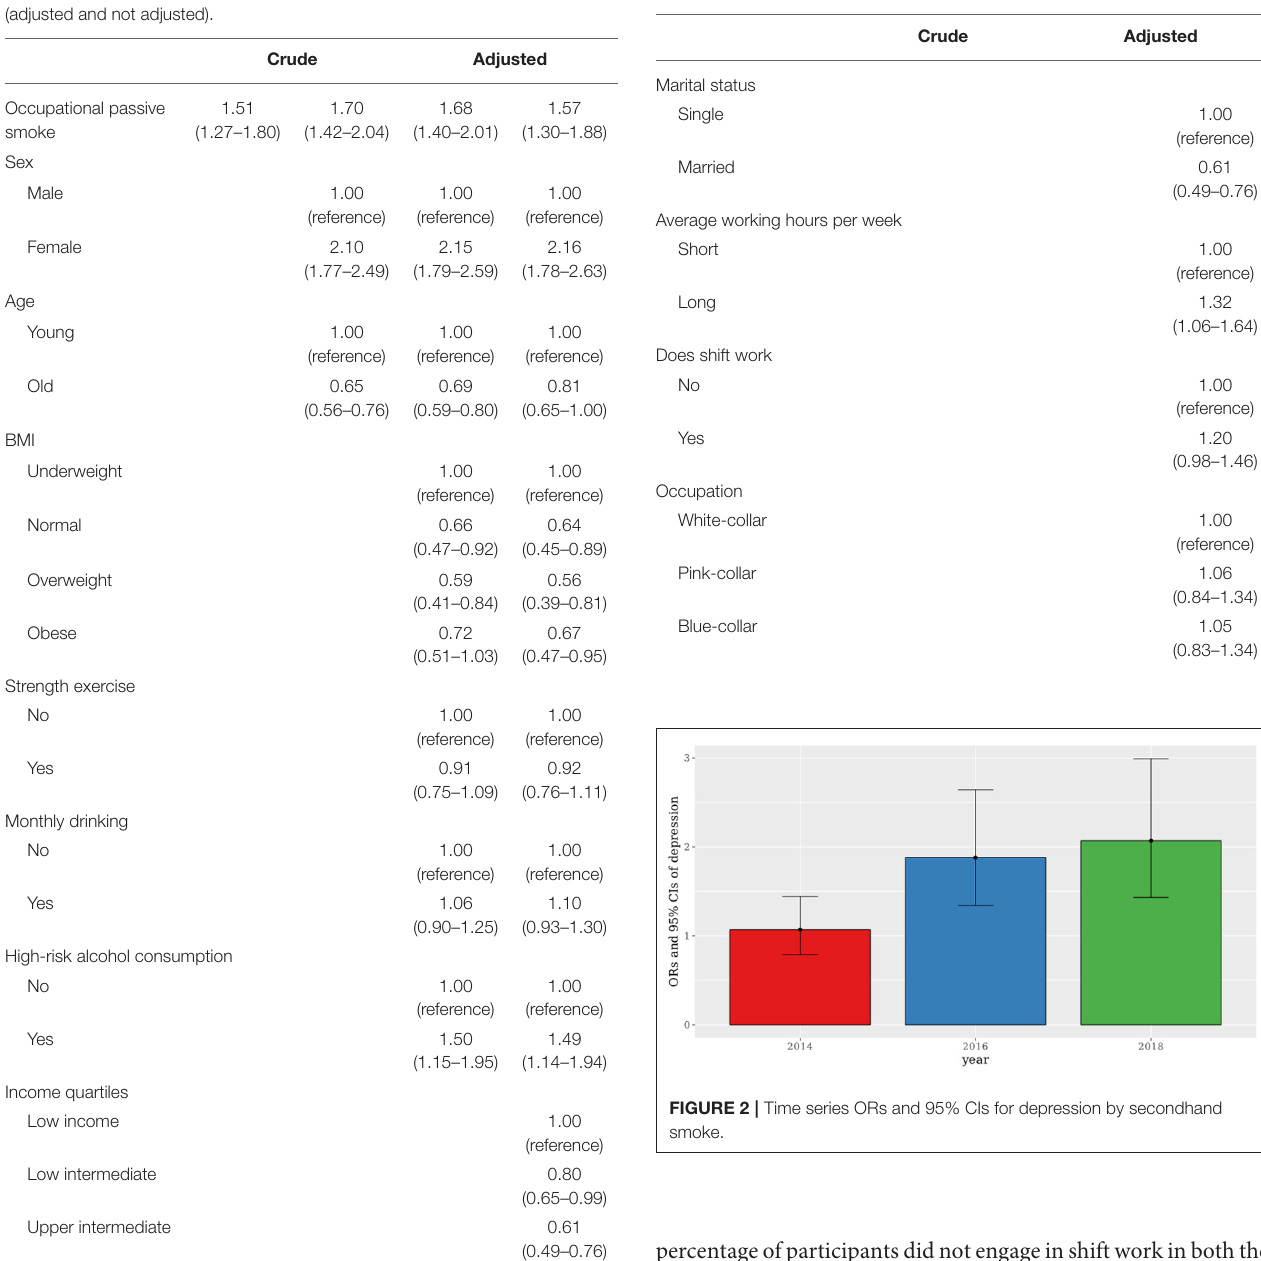
percentage of participants did not engage in shift work in both the exposed and non-exposed groups (82.1 and 83.8%,